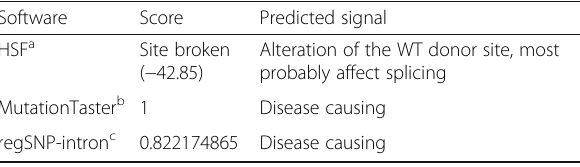
Table 2 The effect of c.773 + 4A > C on protein function by in silico analysis Software Score Predicted signal HSF a Site broken ( −